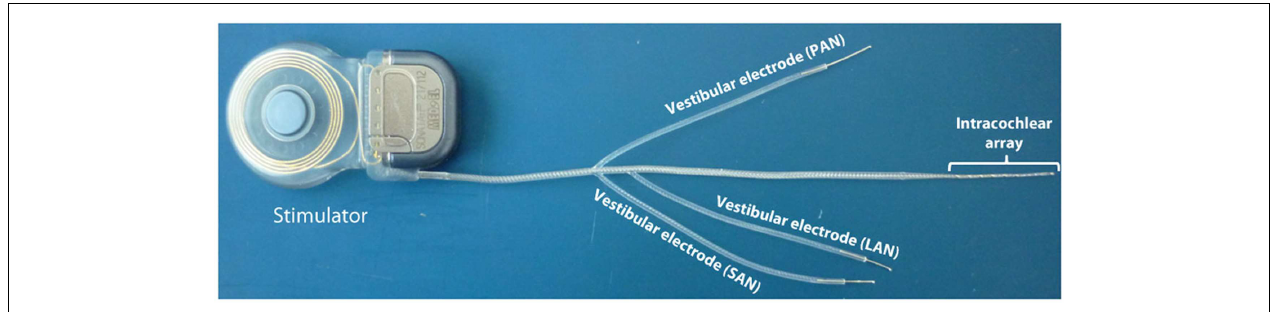
were taken out from the standard intracochlear array. Each of these “vestibular” electrodes was located on the distal tip of separate leads to allow implantation in the posterior, superior, and lateral